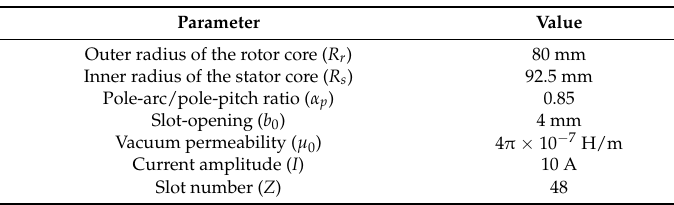
Table 1. Main parameters of